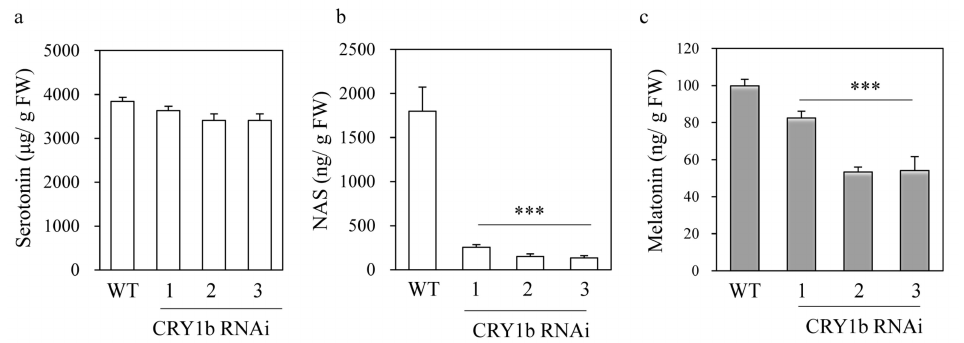
Figure 3. Serotonin, N -acetylserotonin, and melatonin contents in WT and CRY1b RNAi lines. ( a ) Serotonin, ( b ) N - acetylserotonin (NAS), and ( c ) melatonin levels in response to cadmium treatment under cool fluorescent light. Eight-day- old rice seedlings were challenged rhizosperically with 0.5 mM CdCl 2 for 3 days under cool fluorescent light at a rate of 60 µ mol m − 2 s − 1 . Values are presented as the means ± standard deviations (SDs) of three independent experiments. FW, fresh weight. *** p < 0.001, Tukey’s HSD post-hoc test.